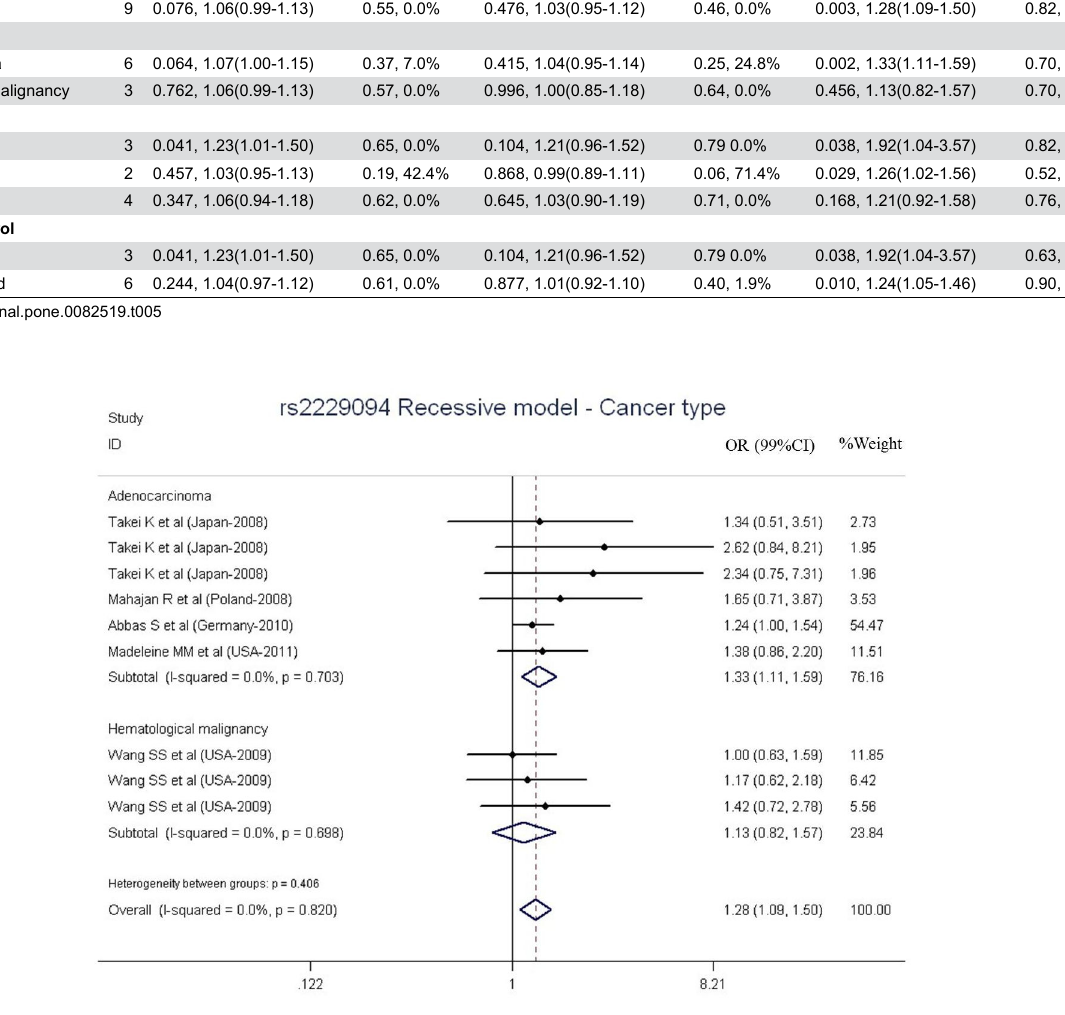
Figure 4. Meta-analysis of LTA rs2229094 polymorphism and cancer risk stratified by cancer type. doi: